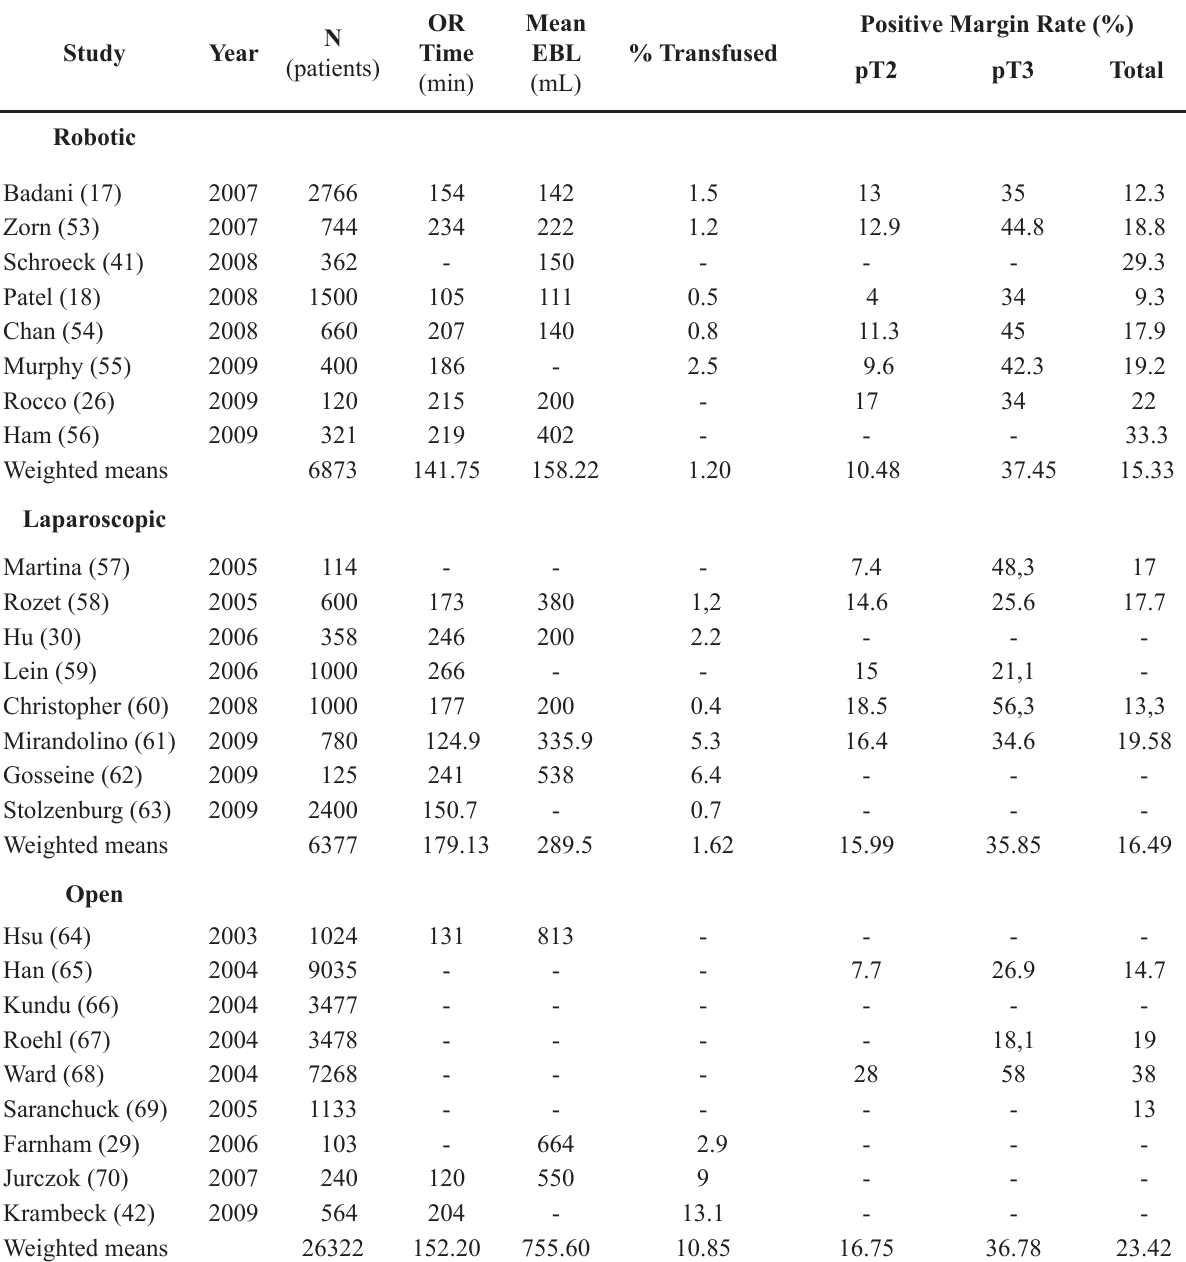
Table 2 – Perioperative results of RRP, LRP and RALP